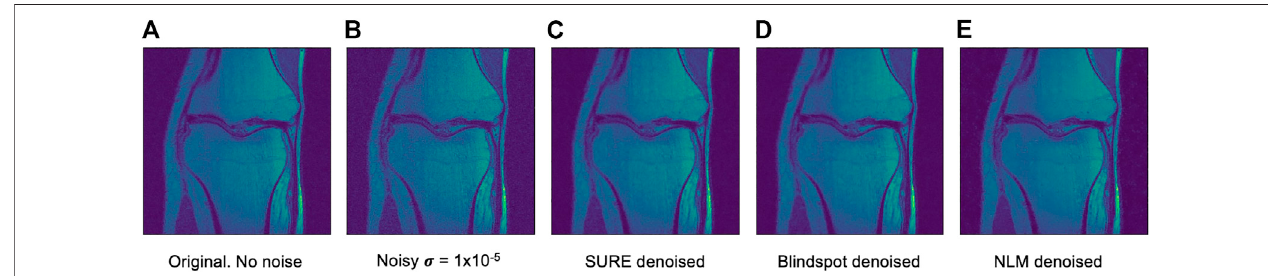
FIGURE5| Example ofdenoisedknee MRIfor σ (cid:1) 1 × 10 − 5 .Theexampleimageisthemiddleslicefromoneofthesubjects.Inthiscase,thisisthePSNRforevery